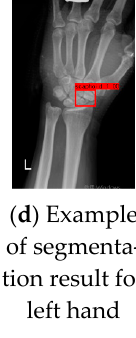
Figure 3. Examples of segmentation results using YOLO-v4.